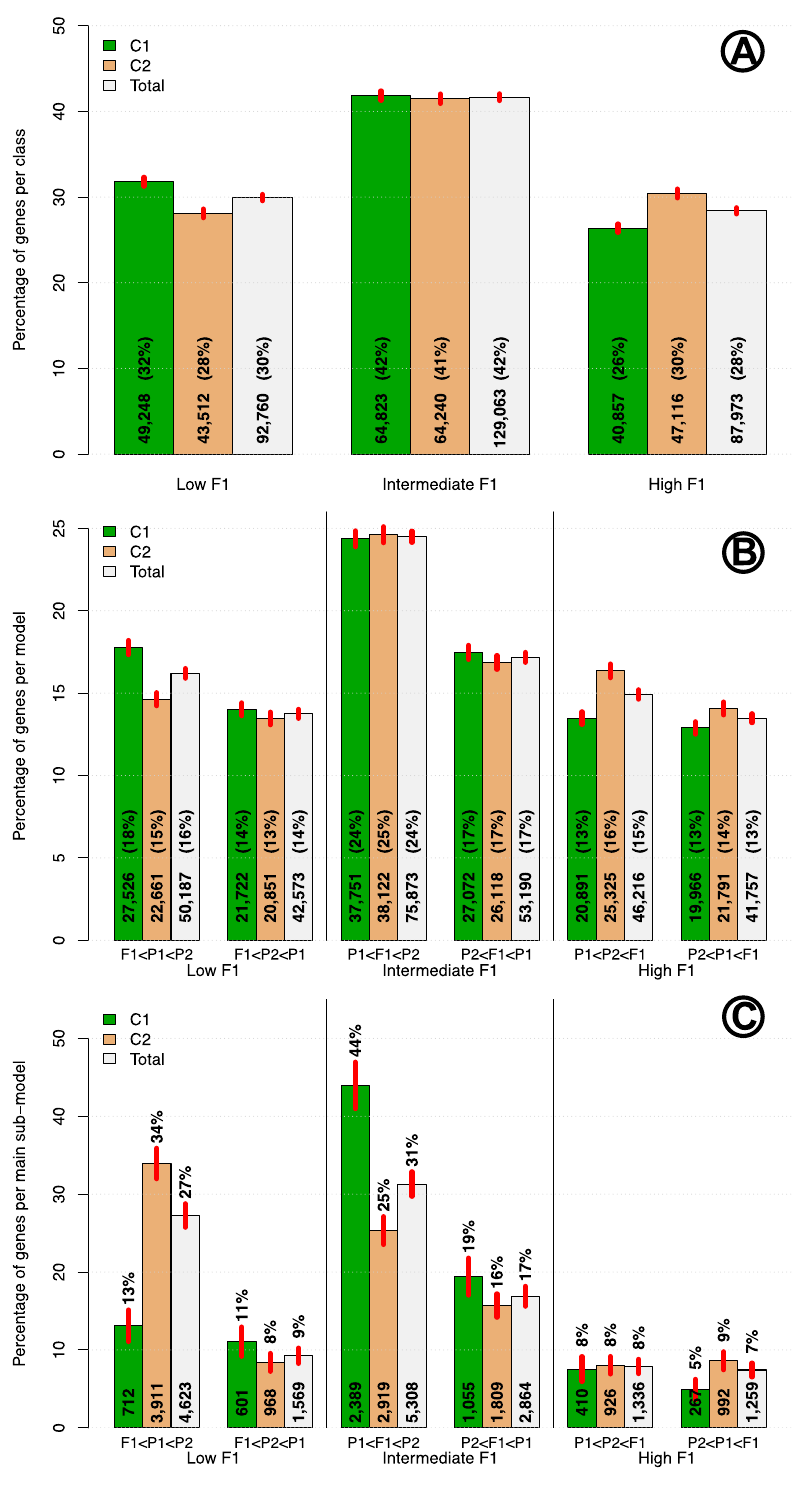
Figure 2. Frequency of class, model and main sub-model per cross over all times of fruit development. Colored bars give percentages for cross C 1 , C 2 and the Total of both crosses. Red lines in the middle of the top of bars are − 5 Confidence Intervals (CI) for percentages with α = 1 × 10 . Numbers in bold at the base of each bar give raw number of cases. Rounded percentages are given in bars in panels (A,B) , and above bars in panel (C) . Panel (A) Frequency per class; Panel (B) Frequency per model; Panel (C) Frequency per main significant